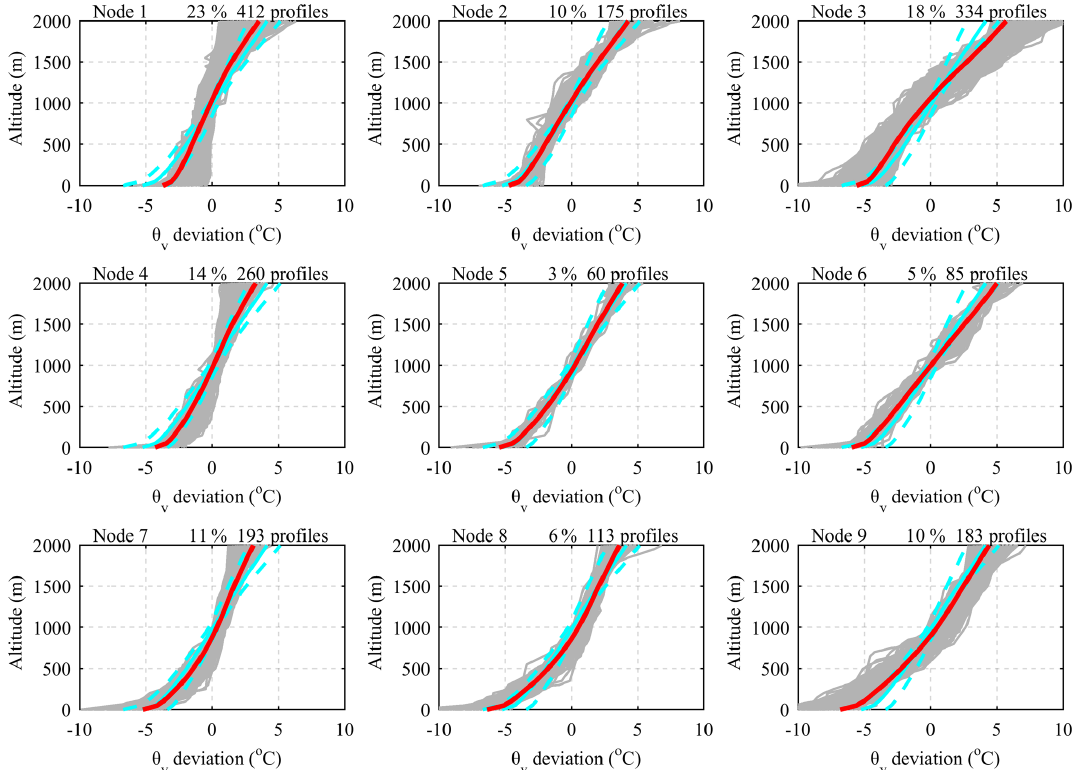
Figure 1. The 3 × 3 SOM output for radiosonde-based virtual potential temperature ( θ v ) deviation profiles observed at the Beijing Observa- tory. SOM nodes are shown in red, with the corresponding individual profiles in grey. For reference, the overall average θ v deviation profile and 25 and 75th percentile profiles are shown in cyan. The top right of each panel shows the occurrence cases and frequency of each SOM node.